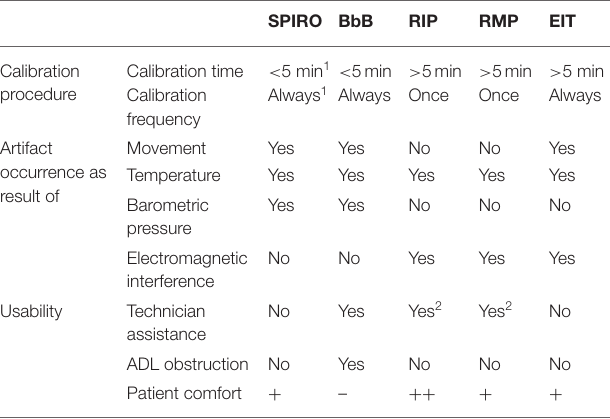
TABLE 1 | Overview of evaluation handhold spirometers (SPIRO), breath-by-breath-analyzers (BbB), respiratory inductance plethysmography (RIP), respiratory magnetic plethysmography (RMP) and electrical impedance tomography (EIT) on calibration procedure, artifact occurrence and